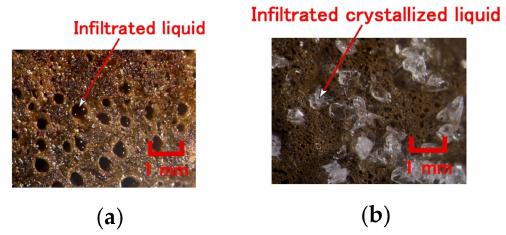
Figure 18. Images of porous MCF rubber after percolation by evacuation (0.5 g Na 2 WO 4 · 2H 2 O, 3 g KF96, 3 g PVA, 0.75 g MF, 0.5 g TiO 2 , 3 g S-500, 3 g 671A, and 3 g Ni): ( a ) KI + I 2 ; ( b ) adipic